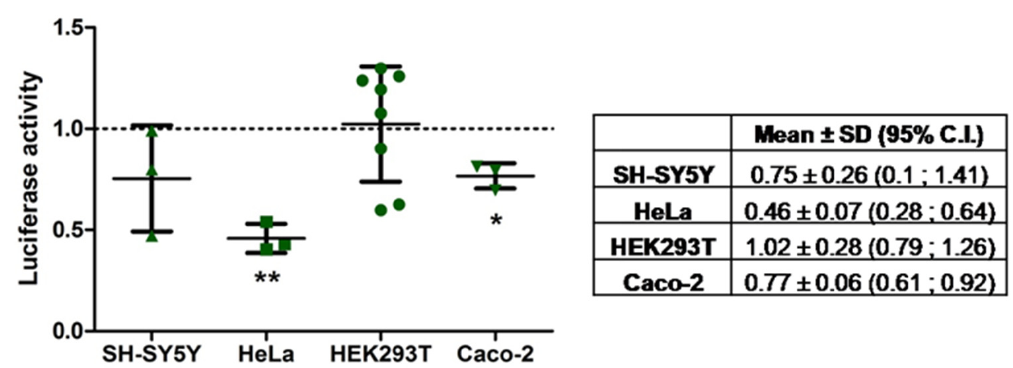
Figure 2. Endogenous regulation of pmiRGLO-3 (cid:48) -UTR-COVID-19 plasmid expression in different human cell lines. Dot plot represents the firefly/Renilla luminescence ratio of the 3 (cid:48) -UTR construct in each cell line and experiment normalized to the ratio from pmiRGLO construct for the same cell line and experiment. Overlaid line plot represents the mean ± SD of, at least, three experiments, and the dotted line represents the reference value for pmiRGLO construct (equal to 1 after normalization). An extended figure with all experimental replicate data points is available in Figure S1. The associated table summarizes the mean ± SD with 95% of C.I. of three independent experiments except for HEK293T, which comprises eight independent experiments, including the data from the reporter assays described below. In HeLa and Caco-2 cells, the 95% C.I. did not include the reference value of pmiRGLO indicating a significant ( p < 0.05) regulation of the SARS-CoV-2 3 (cid:48) -UTR. SH-SY5Y and Caco-2 cells showed a moderate endogenous regulation of the expression of the SARS-CoV-2 3 (cid:48) -UTR. HeLa cells reduced luciferase activity of the SARS-CoV-2 3 (cid:48) -UTR to more than 50% compared to the pmiRGLO. In HEK293T cells, the luciferase activity between both plasmids was very similar, so there was no endogenous regulation by these cells. * indicates a p -value < 0.05 and ** p -value <